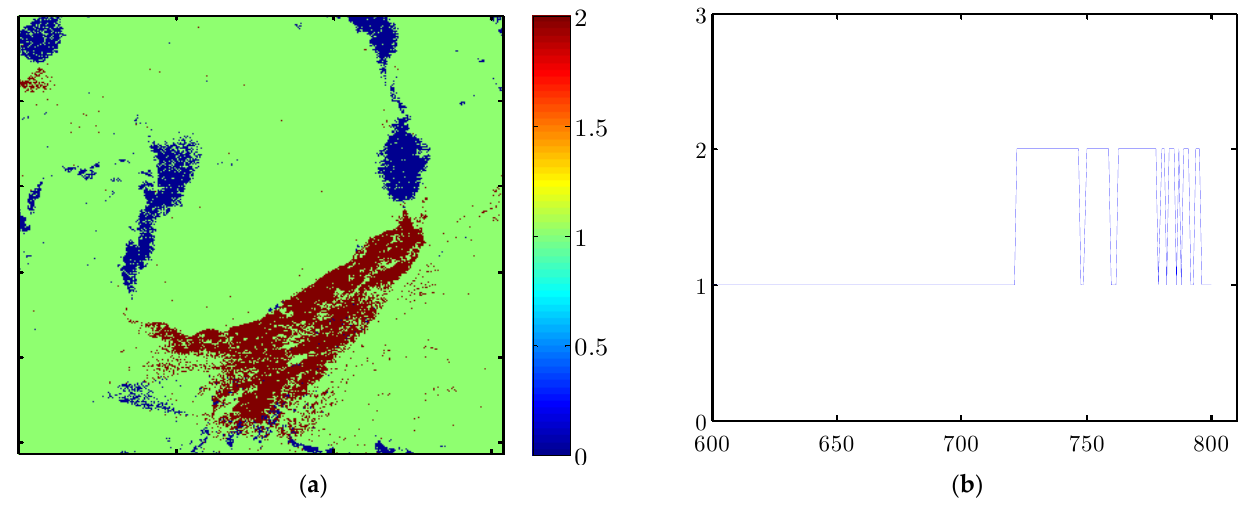
Figure 4. Number of scattering points. ( a ) Distribution of the number of scatterers, where the horizontal axes represent the azimuth direction, and the vertical axes represent the slant range direction.; ( b ) Profile of number of scatterers, the horizontal axes represent pixels from 600 to 800 in the slant range, and the vertical axes represent the number of scatterers in the current pixel.